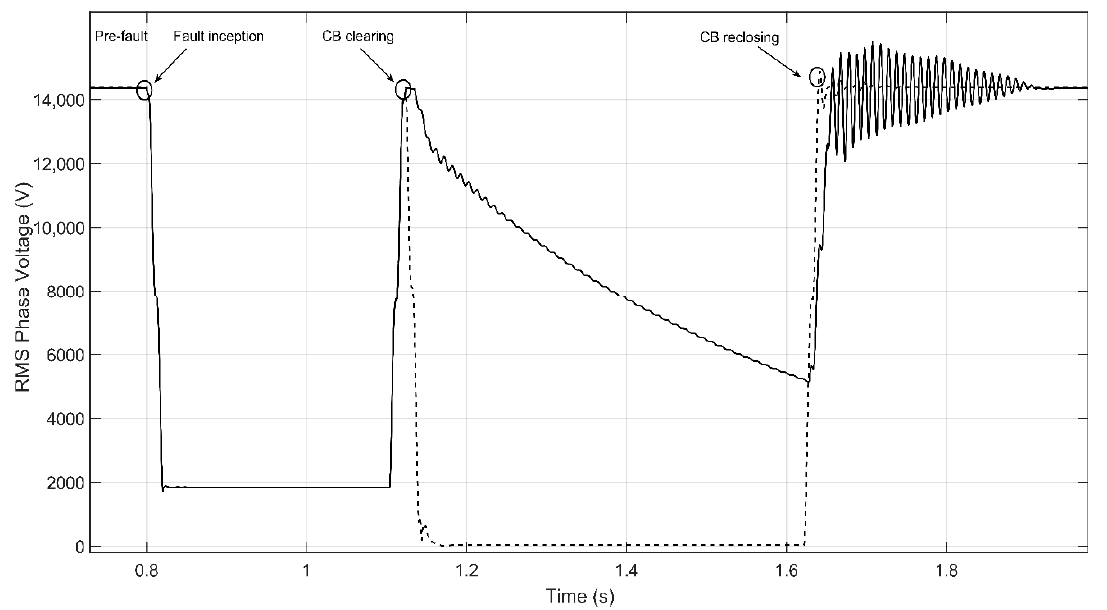
Figure 5. Comparison between scenarios, distribution network (DN) with IMs (solid line) and without IMs (dashed line).